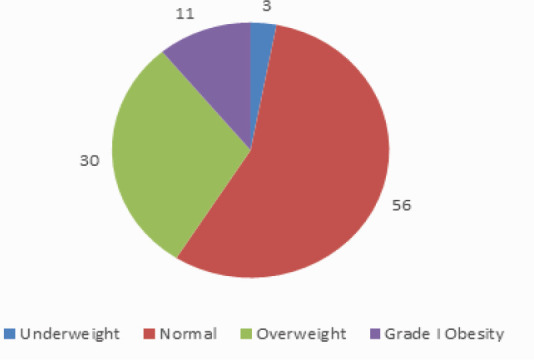
BMI of patients.